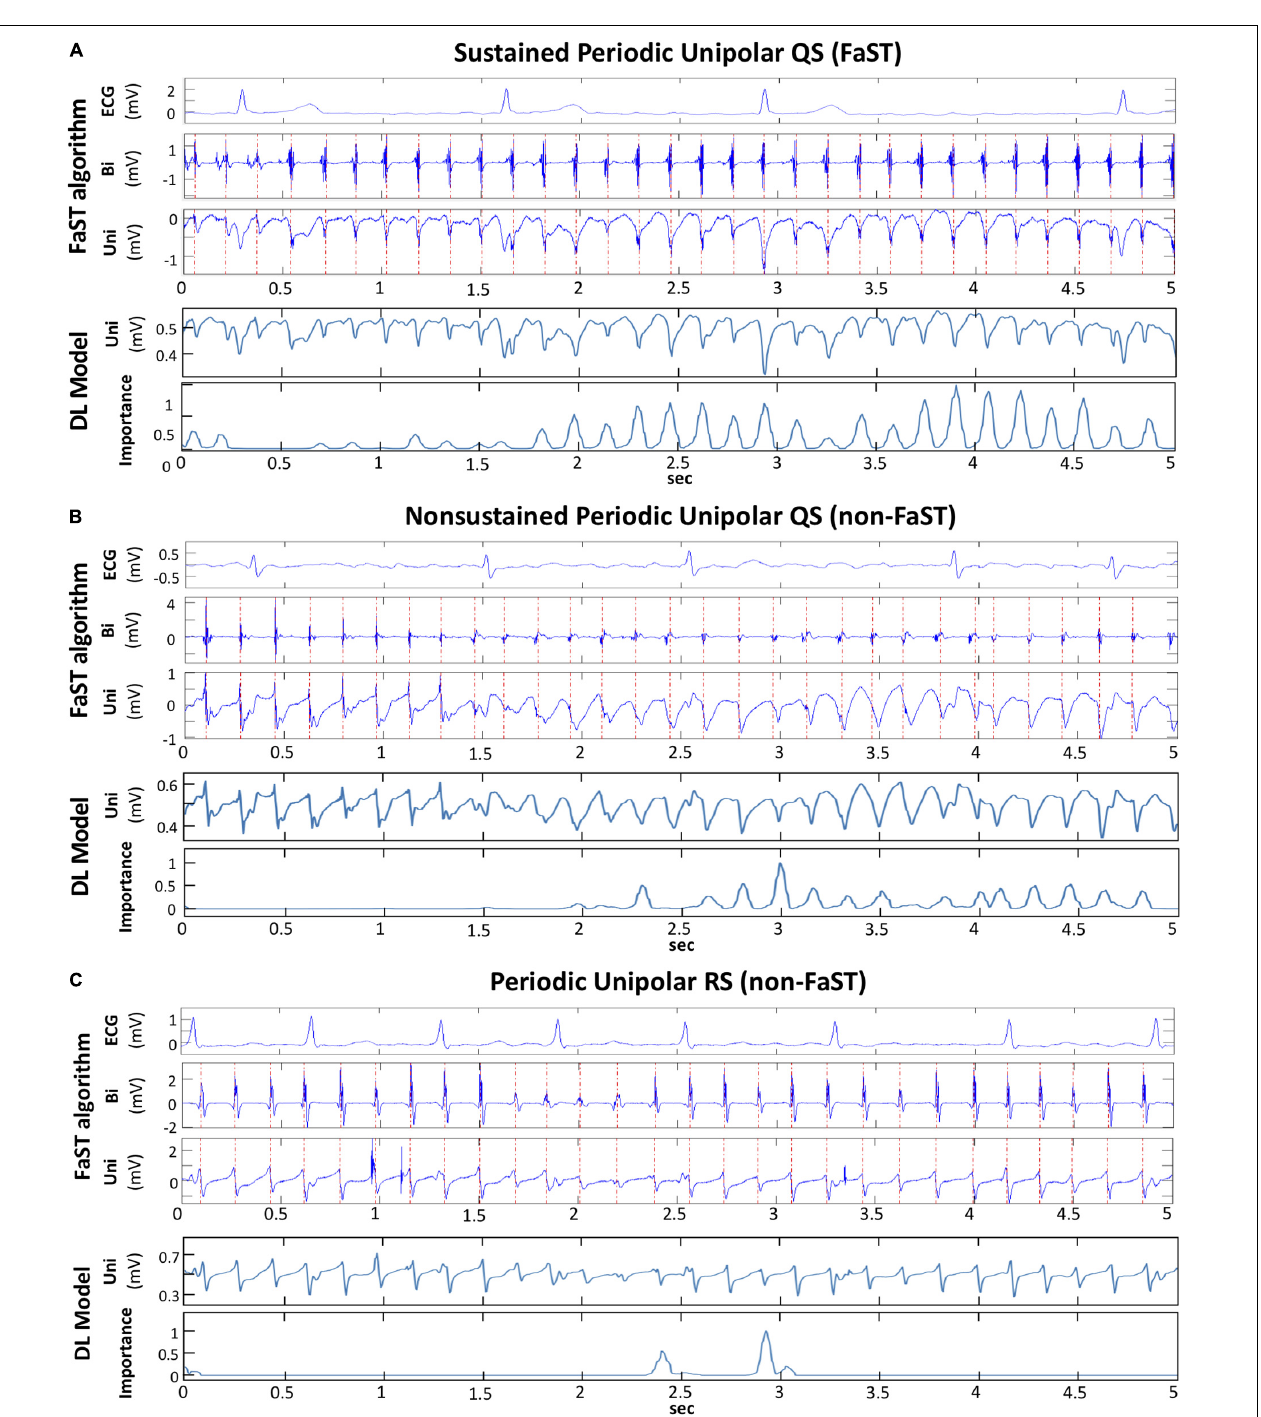
FIGURE 6 | Discretization of DL model to explain classification. (A) FaST site defined by the FaST algorithm based on sustained, periodic unipolar QS for 5-s. Bipolar EGM and unipolar EGM are shown with dashed, red vertical lines annotating periodic activations. The DL model inputs the raw unipolar EGM without annotations and the importance plot from convolutional layer 3.0 demonstrates peaks corresponding to the majority of atrial unipolar QS complexes, but not the far-field ventricular complexes during the 5-s recording. (B) Non-FaST site defined by the FaST algorithm based on non-sustained periodic unipolar QS. The first 8 complexes are unipolar RS, while the rest are unipolar QS. The importance plot from the DL model’s convolutional layer 3.0 demonstrates peaks corresponding to the majority of atrial unipolar QS complexes, but not the atrial unipolar RS complexes. (C) Non-FaST site defined by the FaST algorithm based on the absence of unipolar QS complexes. Accordingly, the importance plot from the DL model’s convolutional layer 3.0 demonstrates virtually no peaks. There are 2 peaks which correspond to atrial unipolar rS complexes, similar in morphology to QS complexes.